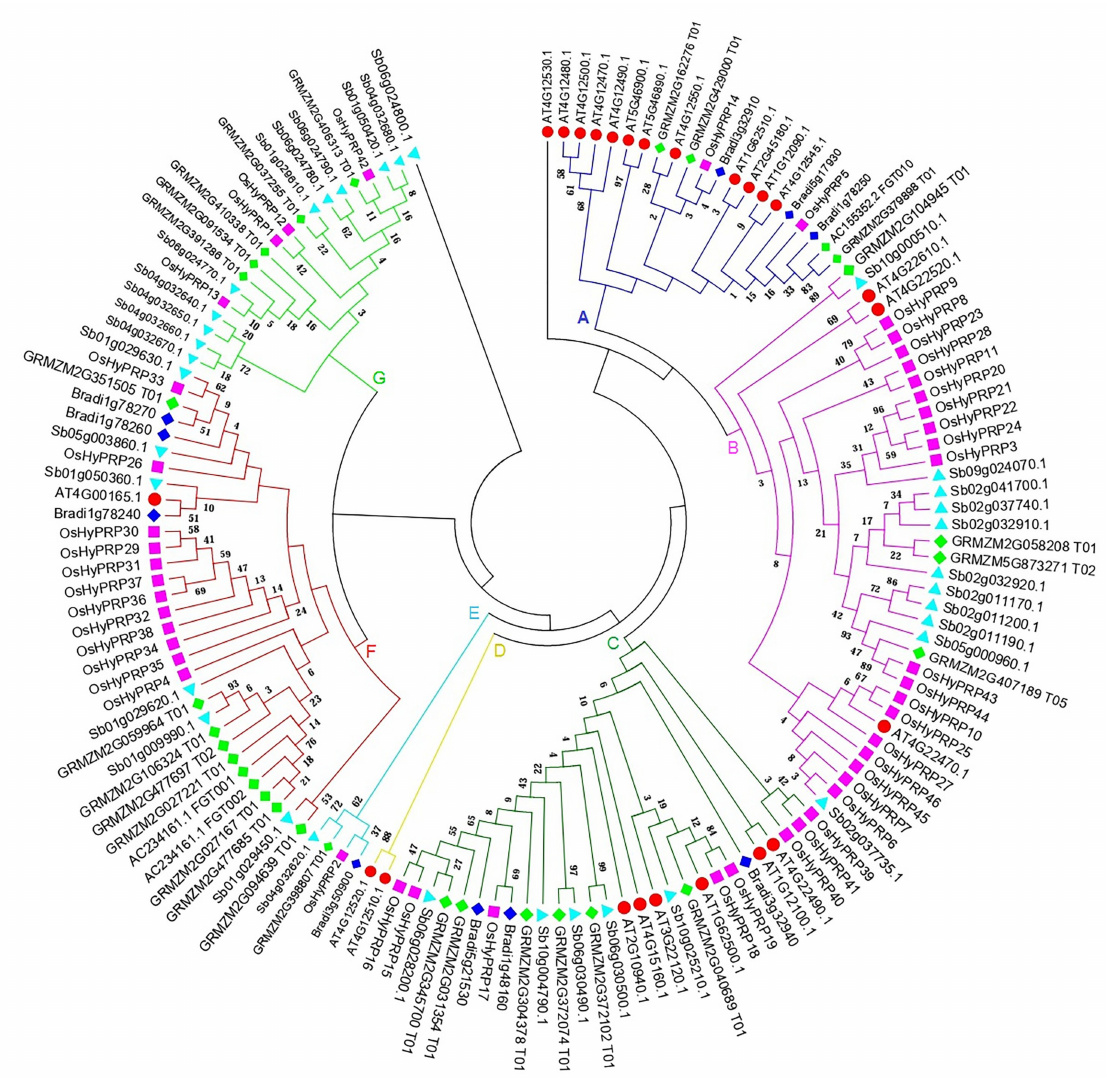
Figure 3. Phylogenetic relationship of rice HyPRPs with that of Arabidopsis, maize, sorghum and B. distachyon. The 8CM region of all the HyPRPs was used to construct the phylogenetic tree. The multiple sequence alignment and phylogenetic tree construction were performed with MEGA6.06 using maximum likelihood method with 500 bootstrap replicates. The di ff erent shapes with color code represent the HyPRPs of di ff erent plant species; red sphere for Arabidopsis, magenta square for rice, cyan triangle for sorghum, lawn-green diamond for maize, and blue diamond for Brachypodium . The one protein each from sorghum and Arabidopsis does not group with other HyPRPs and thus considered as highly divergent